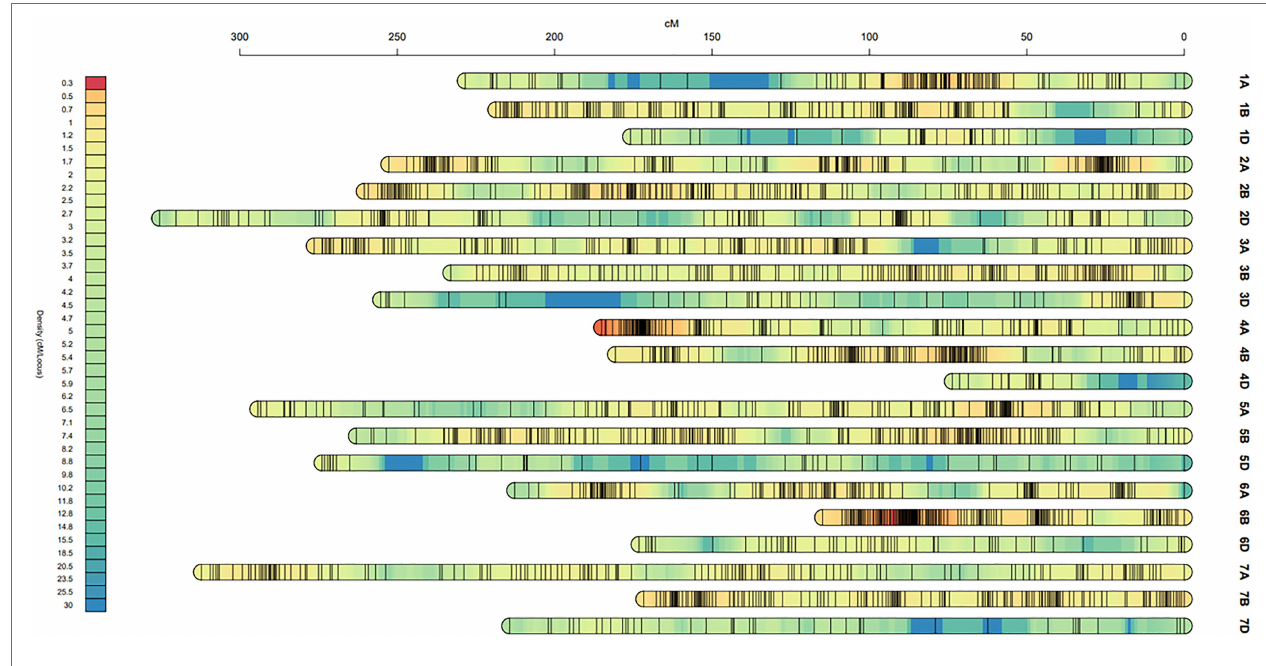
FIGURE 2 | Genetic map constructed from the DH lines from Baiqimai/Neixiang 5.